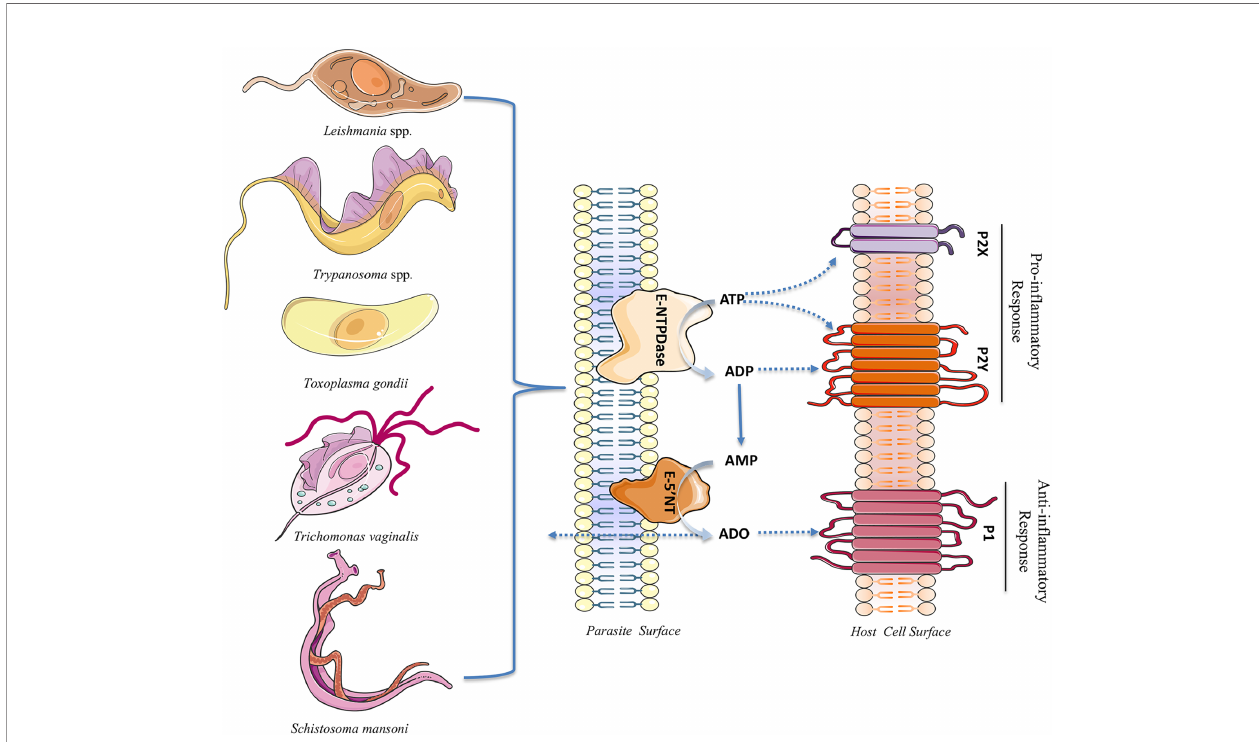
FIGURE 1 | Extracellular nucleotidases in parasite cell surface and nucleotide/purinergic signaling in the host cell. During infection, the immune system interprets an increase in the levels of extracellular ATP as a risk situation and gives rise to an in fl ammatory response through the activation of P2X and P2Y receptors, culminating in parasitism control. In the parasite surface the enzyme NTPDase hydrolyzes extracellular ATP to ADP and ADP to AMP. The AMP generated can be subsequently hydrolyzed to adenosine (ADO) by Ecto-5 ’ -nucleotidases (E-5 ’ NT). Adenosine reduces the host in fl ammatory response via P1 receptors to favor the persistence of parasite in the infected cells. Changes in extracellular nucleotide and adenosine levels can modulate P2 and P1 receptors activity (the images used in the illustration are provided by